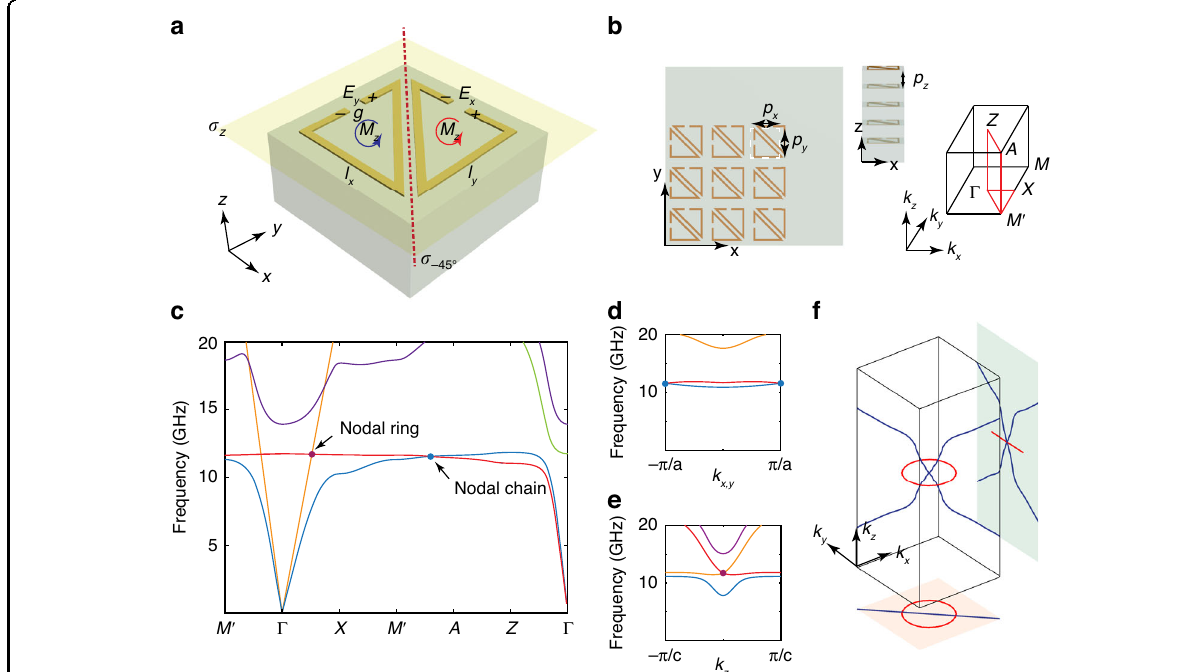
Fig. 3 Realistic bi-anisotropic metamaterials with in-plane nodal chain and nodal link. a Schematic of the bi-anisotropic metamaterial. Split- ring resonators are arranged on the σ z mirror plane. The resonators also possess another mirror symmetry of σ -45 ˚ as indicated by red dashed line. Side length of the resonator is l x , y = 3.3 mm, and resonance gap is g = 0.5 mm. b The units are repeated to form 3D metamaterials, with lattice constants p x = 4.5 mm, p y = 4.5 mm and p z = 2 mm. The Brillouin zone of the metamaterials is shown to the right. c Numerically calculated band structures, with degenerate points from in-plane nodal chain and nodal ring marked as blue and red dots, respectively. d , e Linear band dispersions along k x,y / k z directions around the blue / red dot marked in c . f Nodal link in 3D momentum space corresponding to metamaterial shown in b , and projections of the nodal link onto the k y − k z (green) and k x − k y (orange)